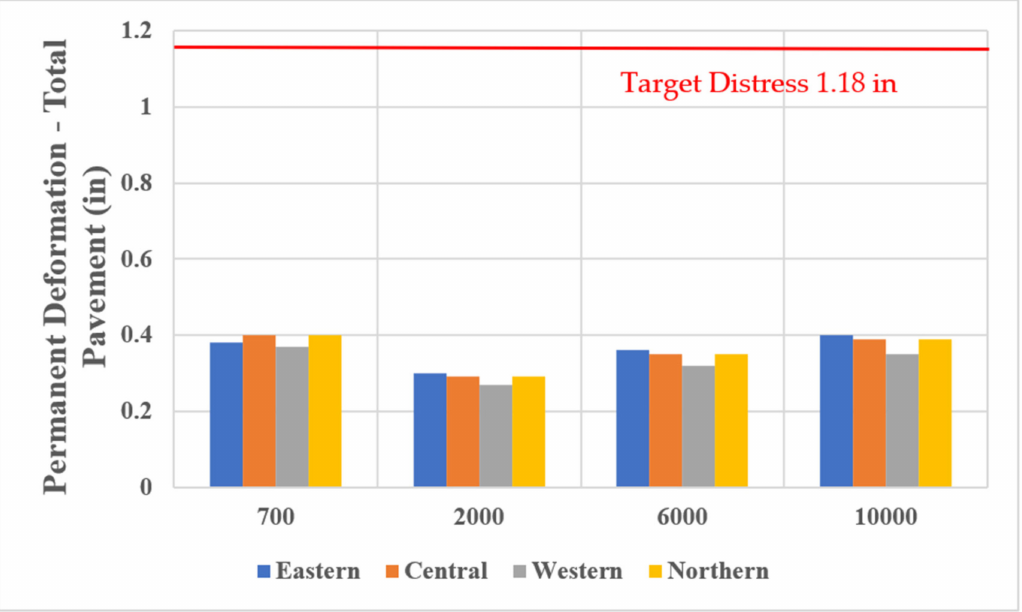
Figure 10. Permanent deformation of total pavement (in) for all different types of traffic for all the regions for 20 years design life.